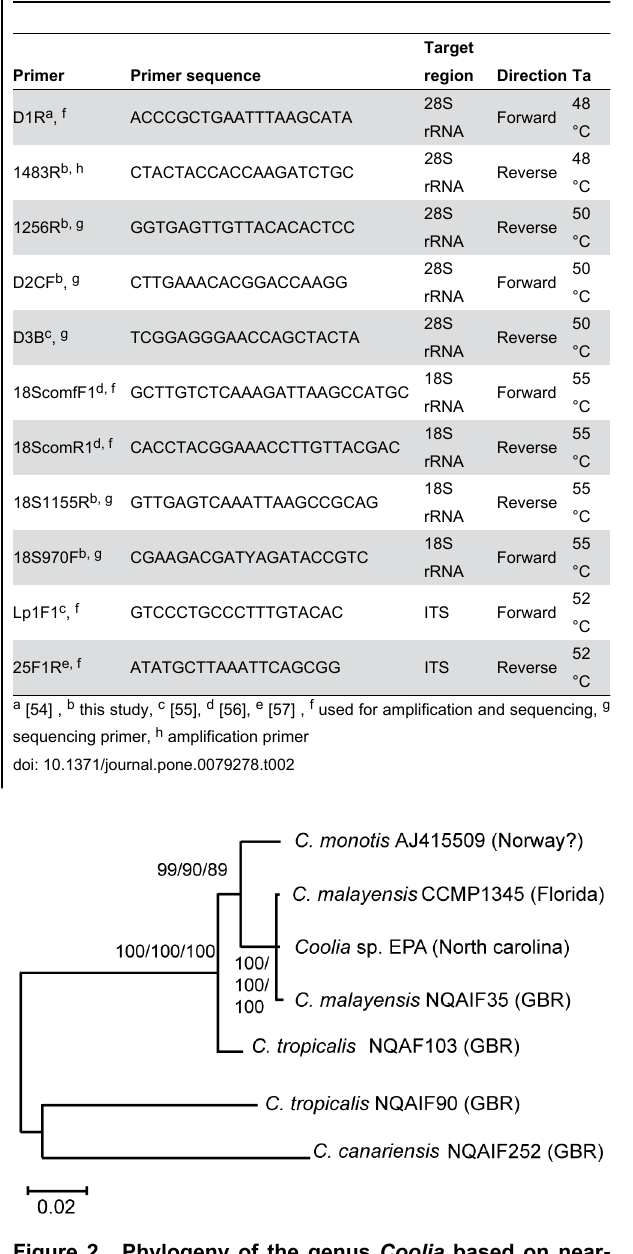
Figure 2. Phylogeny of the genus Coolia based on near- complete 18S rRNA gene sequences. Branch labels indicate Bayesian clade credibility values, and MP and ML bootstrap support, respectively. The tree was midpoint rooted. Scale bar